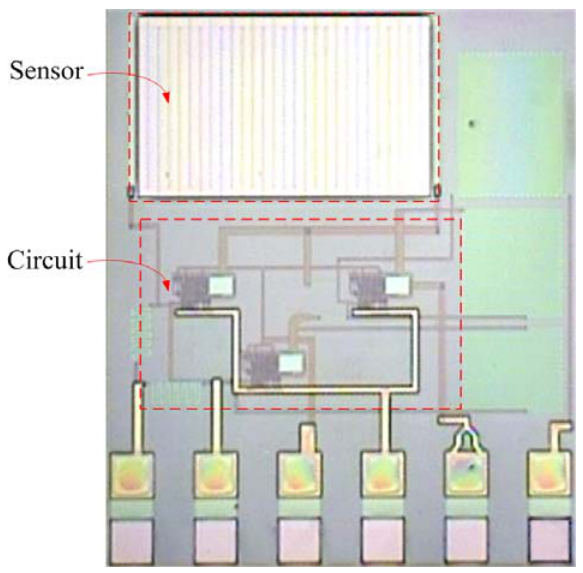
Figure 9. Photographic image of the CO sensor after the CMOS